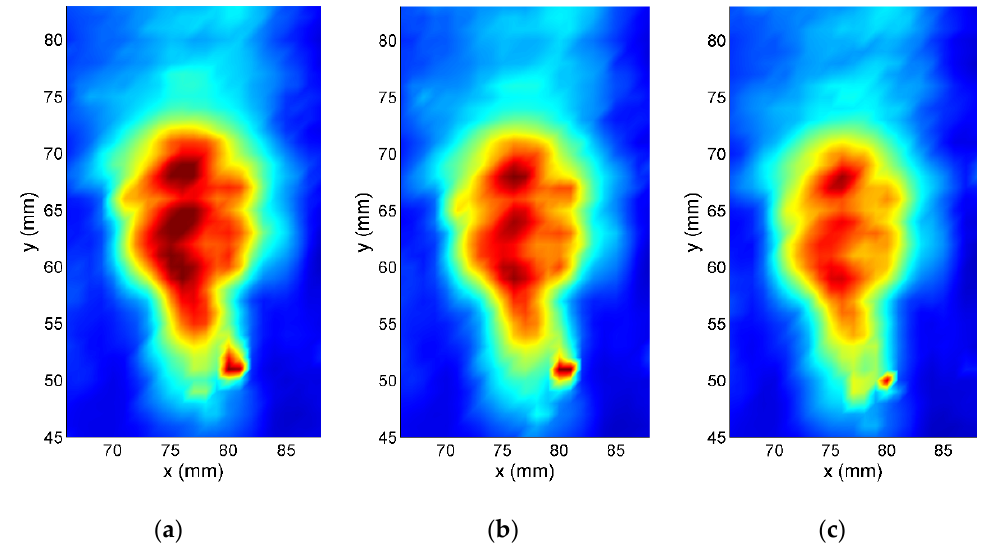
Figure 15. Close-up of BVID (8 J) region ( a ) 1 h, ( b ) 6 h, ( c ) 29 h after the moment of impact.